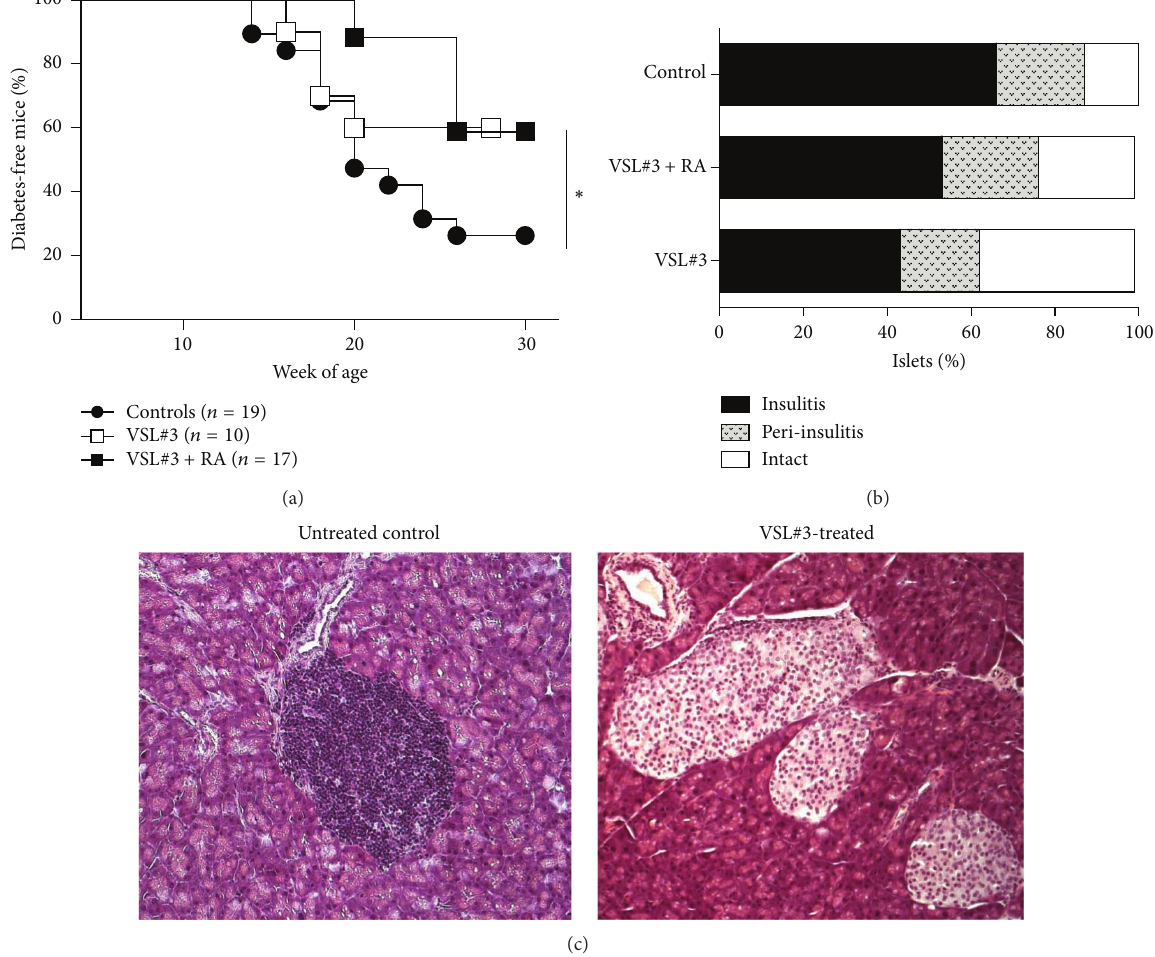
Figure 1: All- trans -retinoic acid (RA) does not enhance the protective effect of the VSL#3 probiotic against autoimmune T1D. (a) VSL#3 (14mg/kg of body weight) was administered orally three times per week alone ( 𝑛 = 10 ) or in combination with RA (i.p.) ( 𝑛 = 17 ). A control group ( 𝑛 = 19 ) received sterile PBS by oral gavage. An additional group received RA alone i.p. All treatments were initiated at 4 weeks of age. Diabetes incidence was evaluated by measuring blood glucose levels staring at 12 weeks of age. For all groups, diabetes was diagnosed after two consecutive measurements of glycemia ≥ 250 mg/dL. Mice were pooled from two independent experiments. The log-rank (Mantel-Cox) test was used for the comparison of diabetes incidence rates between the different groups ( ∗ 𝑝 value < 0.05). (b) The histopathological signs of diabetes were evaluated in pancreatic sections stained with hematoxylin-eosin. The islets were ranked as free of insulitis (intact islets), affected by peri-insulitis (mononuclear cells in the connective tissue around the islets), or affected by insulitis (mononuclear cell infiltration > 20% of the islet). (c) Two representative images of the histopathological analysis are